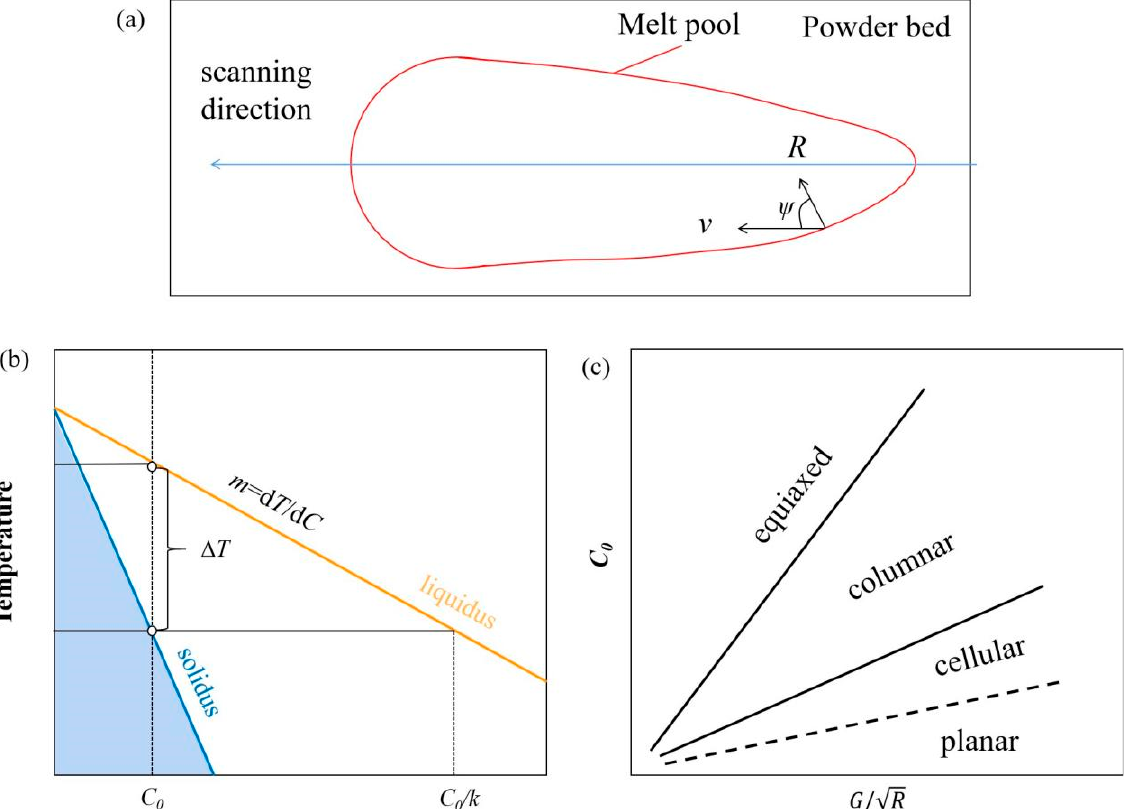
Figure 4. ( a ) Diagram of the relationship between R and v ; ( b ) Schematic representation of constitutional supercooling based on a typical phase diagram; ( c ) Influence of interaction with G , R , and C 0 on grain morphology.